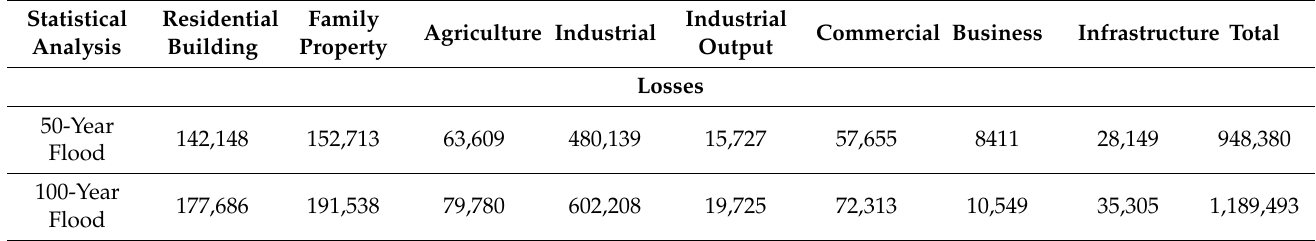
Table 4. Estimated potential losses for flood event scenarios (unit: 10,000